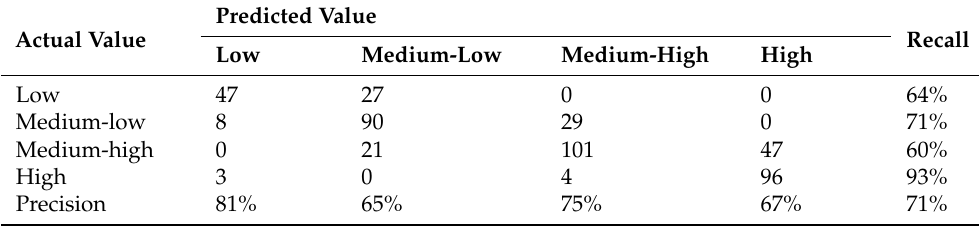
Table 7. Confusion matrix for verification of liquefaction potential grade criteria.